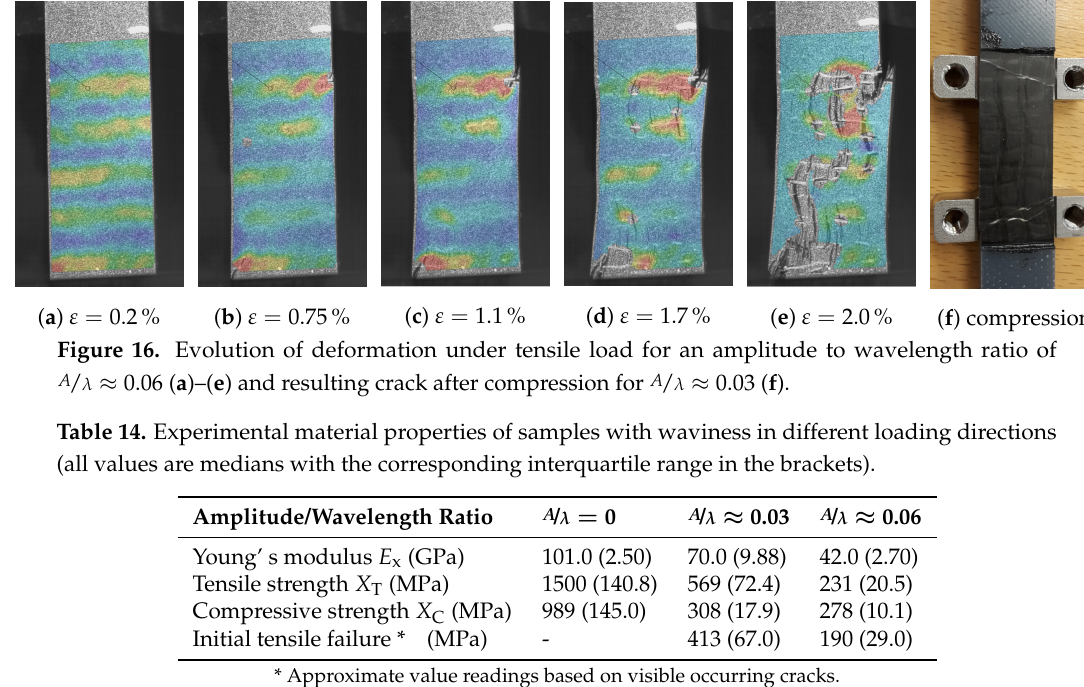
Figure 15. Experimental results of tensile ( a ) and compressive ( b ) tests in comparison to nonundulated UD0° coupon tests.